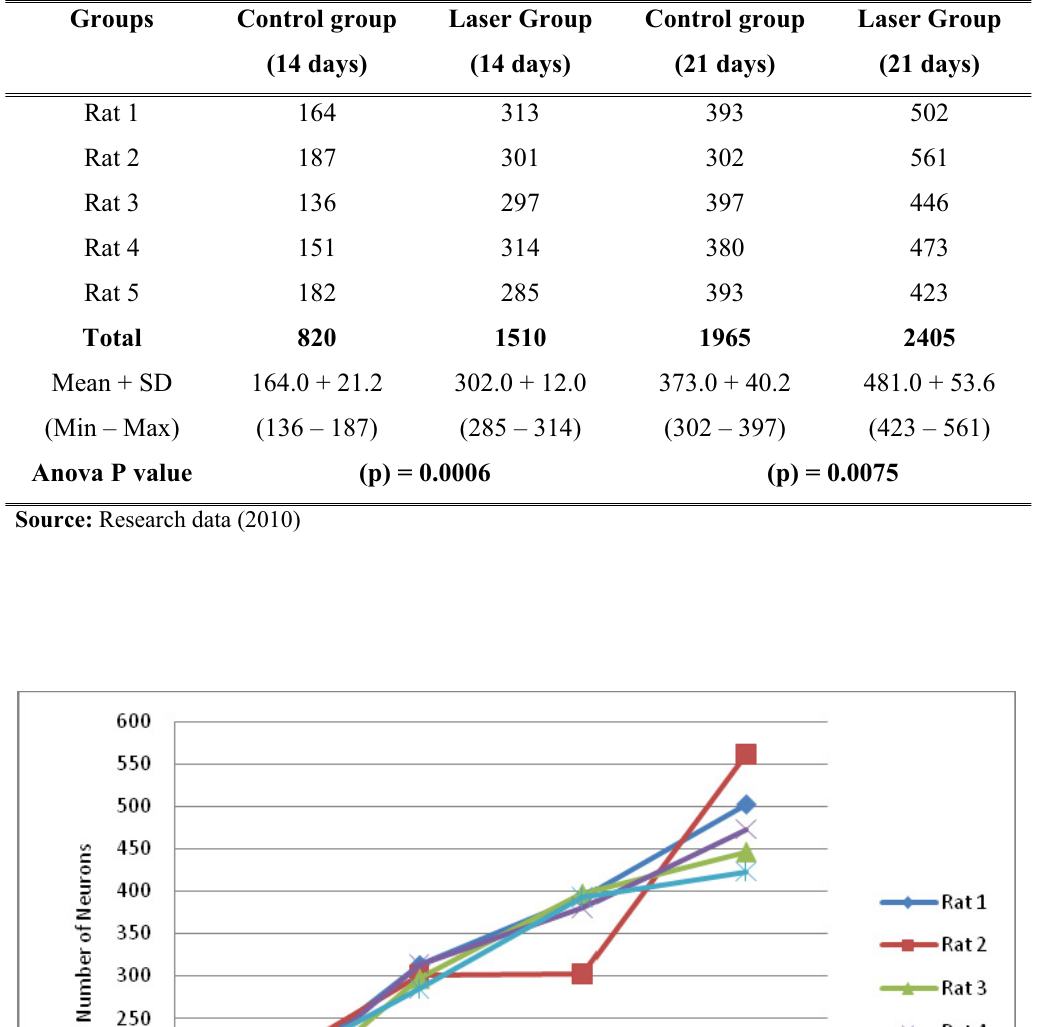
TABLE 1 – Neurons in histological findings at groups in 14 and 21